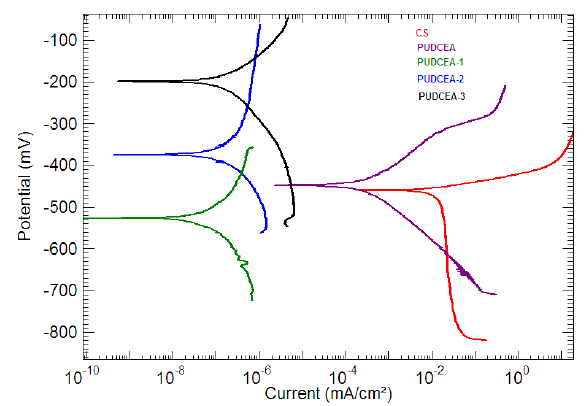
Figure 13. Tafelplot of bare CS, PUDCEA , PUDCEA-1,PUDCEA-2andPUDCEA-3 in NaCl solution.